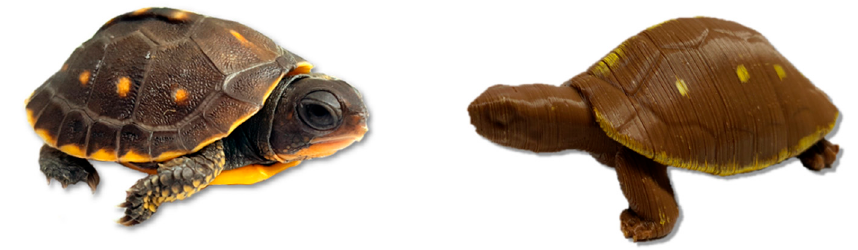
Figure 1. Juvenile eastern box turtle ( Terrapene carolina ) in comparison to a three-dimensional printed turtle model. Photos by Sasha Tetzlaff.